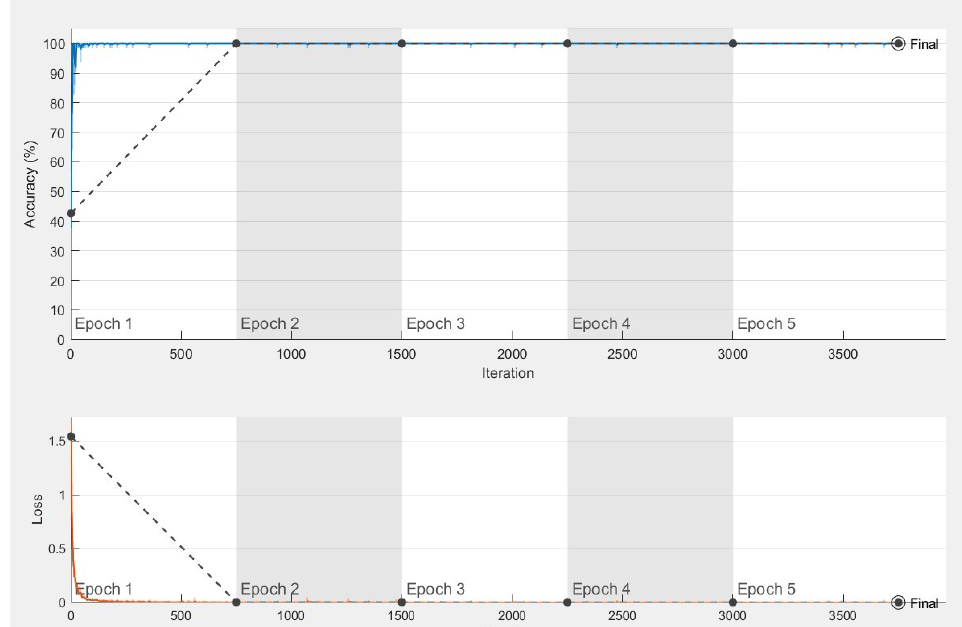
Figure 3. VB-DCNN Training for Case-I.